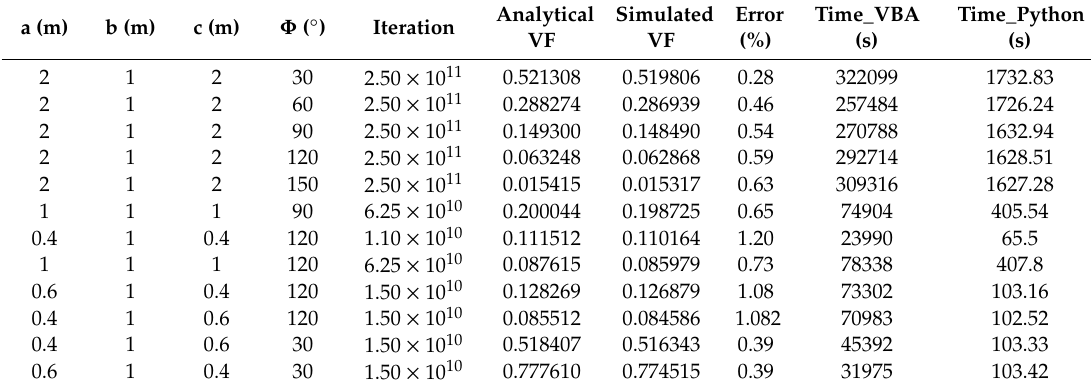
Table A4. View factor for element size h i = 0.002